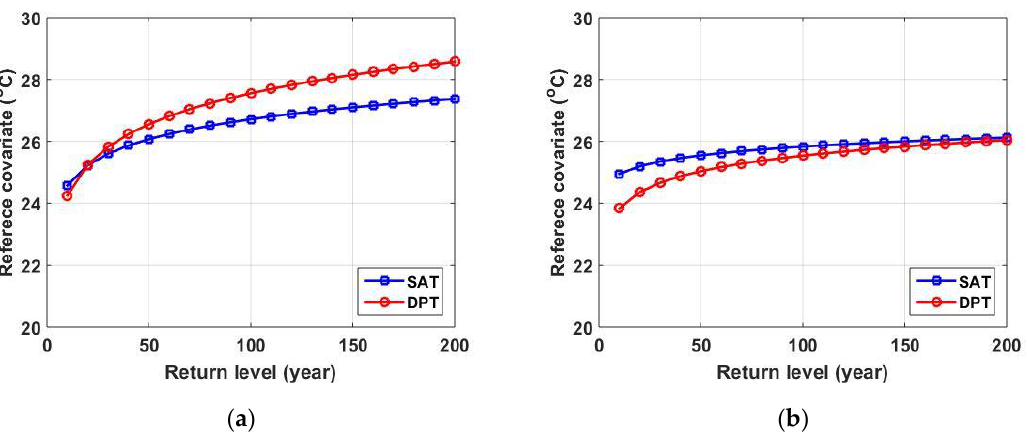
Figure 3. Reference co-variate for various return levels for the annual maximum daily rainfall (AMR) at ( a ) the Chuncheon site, and ( b ) the Cheonan site.